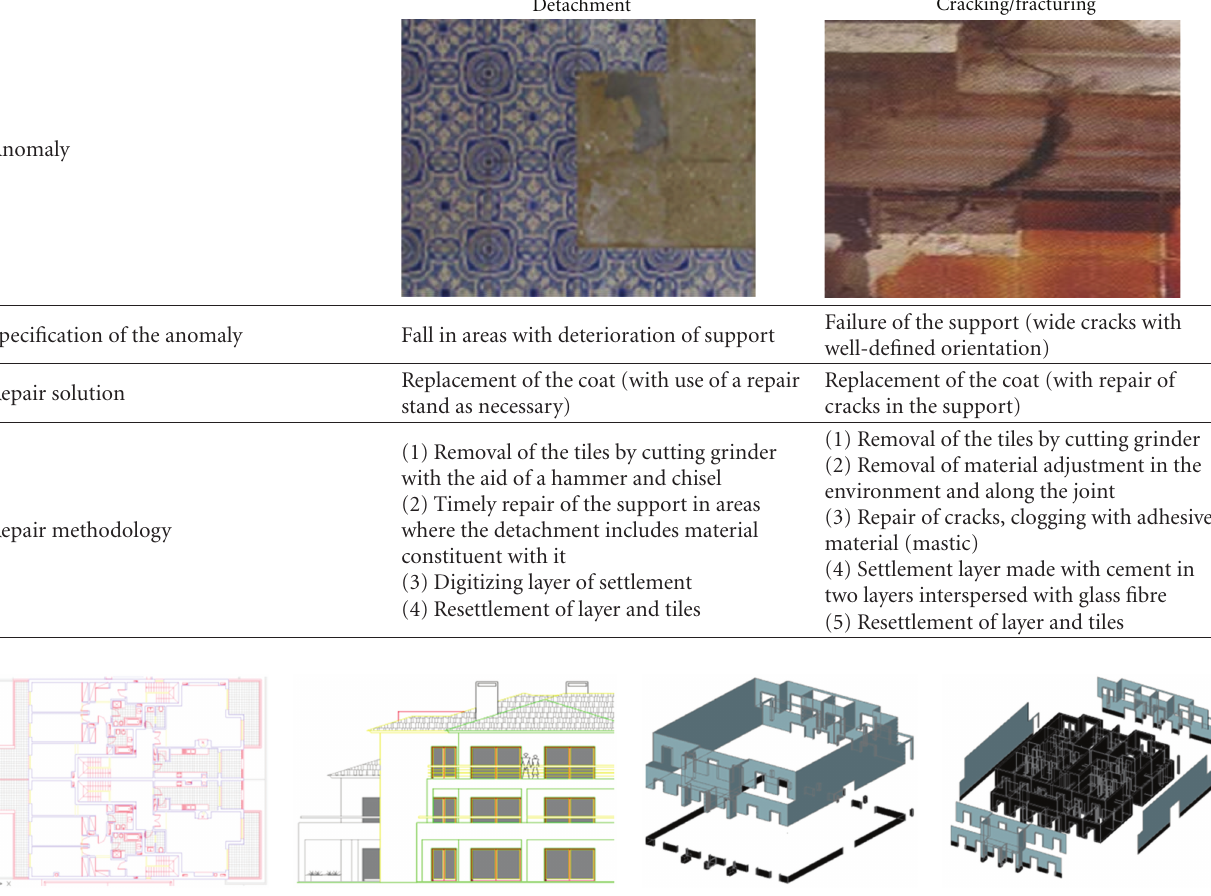
Figure 13: Steps in the geometric modelling